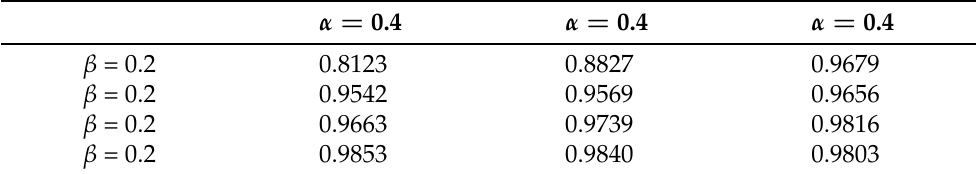
Table 2. Cross-correlation coefficients, Dagum random